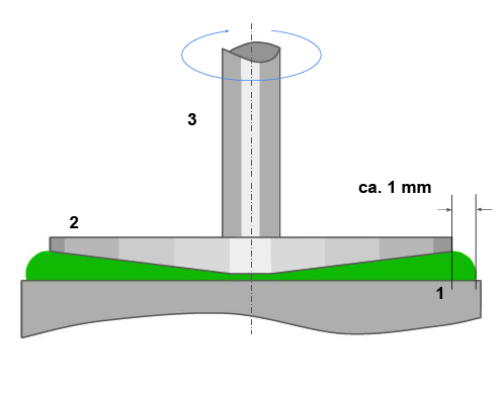
Figure 6. Illustrative scheme for testing using a cone-plane system [27]: 1: base of the measuring system; 2: device of the measuring system (in this case, the cone-plane); 3: shaft leading to the gas bearing of the measuring system.